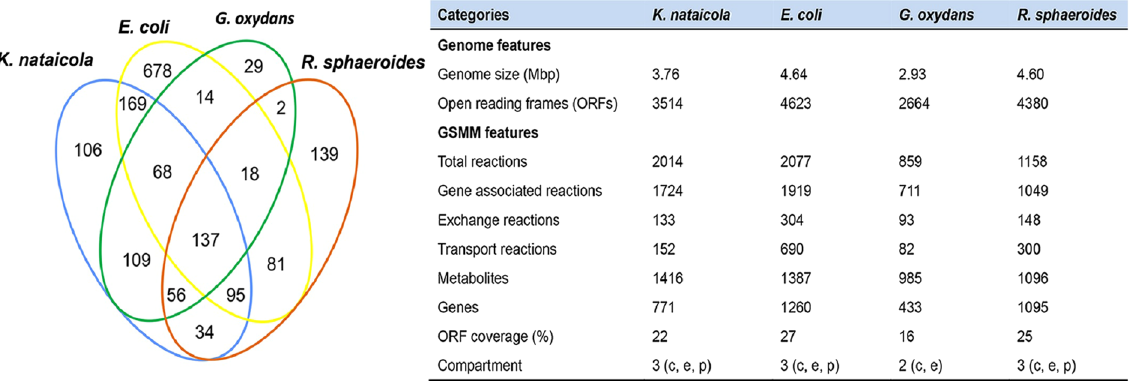
Figure 2. Comparison of general features of i HZ771 with E. coli i AF1260, G. oxydans i XW433, and R. sphaeroides i Rsp1095. Numerical values in each section of the Venn-diagram represent the number of genes that are common or specific to the respective organism.